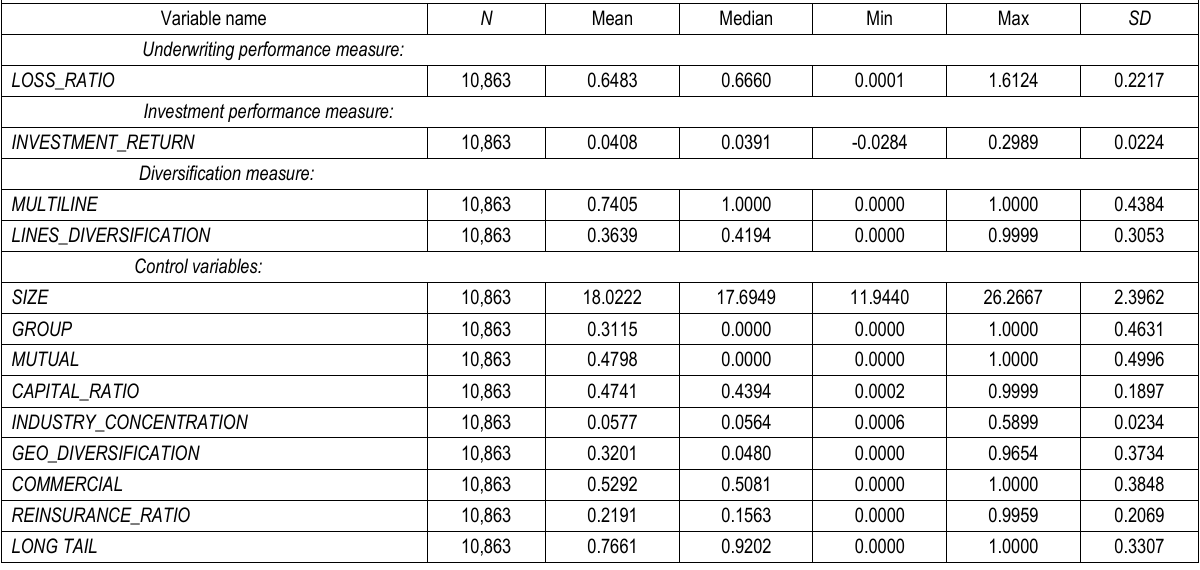
Table 1. Summary